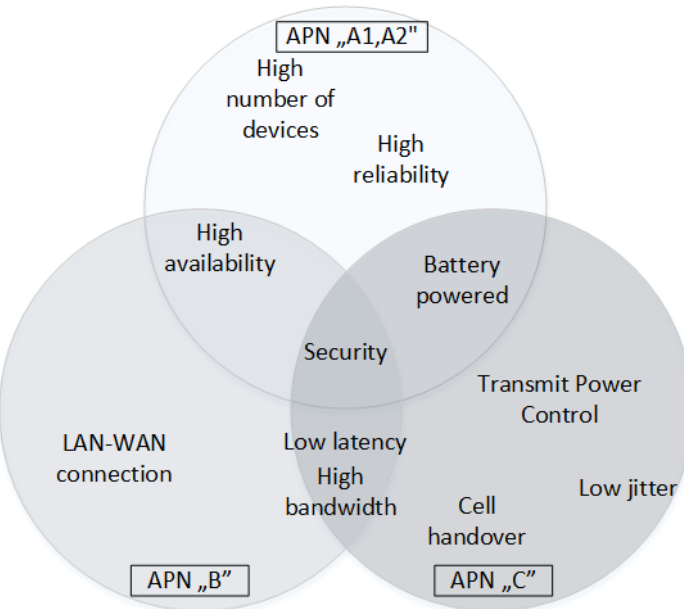
Figure 6. Mapping 5G use-case characteristics to APN traffic scenarios (marking some distinguishing features in this